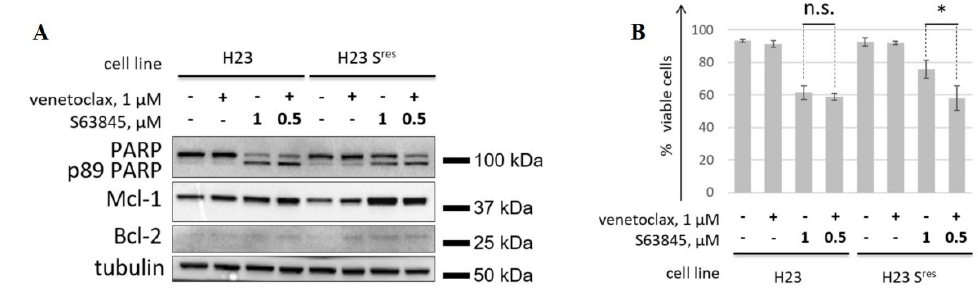
Figure 4. Assessment of the efficiency of concomitant inhibition of Mcl-1 and Bcl-2 in parental H23 cells and H23 cells with acquired resistance to S63845 (H23 S res ). WB analysis ( A ) and FACS analysis ( B ) of H23 and H23 S res cells treated with S63845 and venetoclax alone (1 μ M each) or with their combination (0.5 μ M S63845 and 1 μ M venetoclax). It is important to note that the combination venetoclax 1 μ M + 0.5 μ M S63845 allowed to reduce by half the dose of the latter in order to prevent